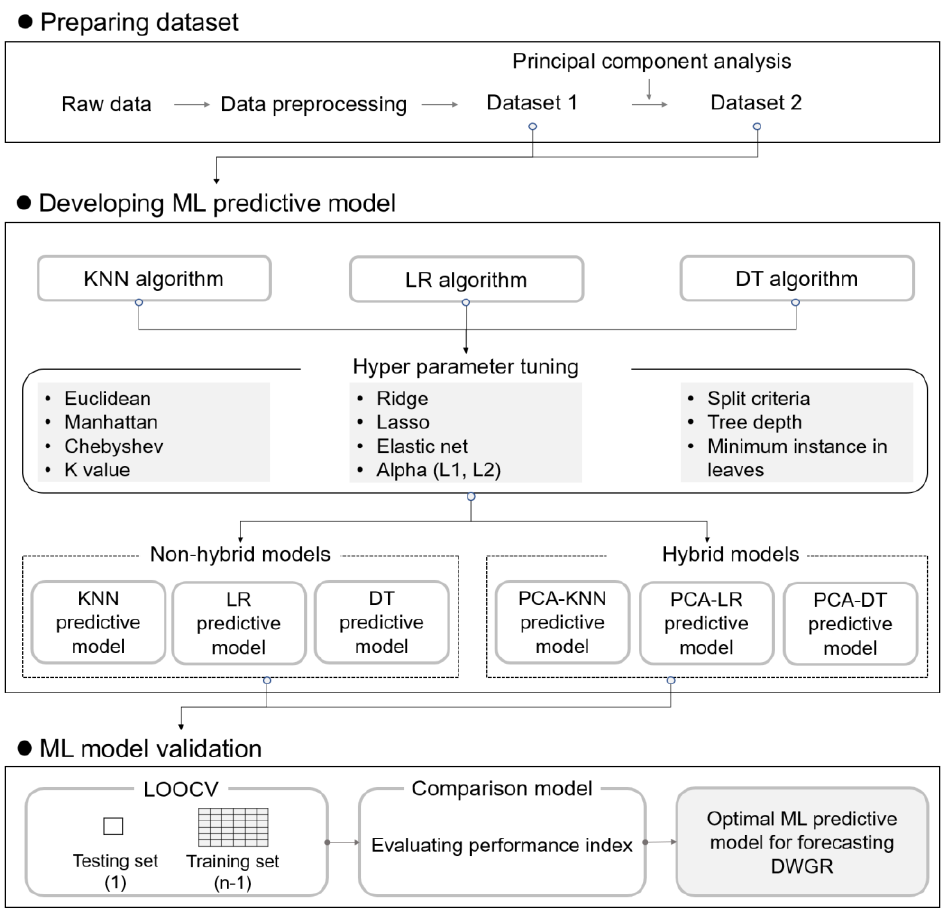
Figure 1. Research workflow used in developing the demolition-waste-generation rate (DWGR) predictive model.